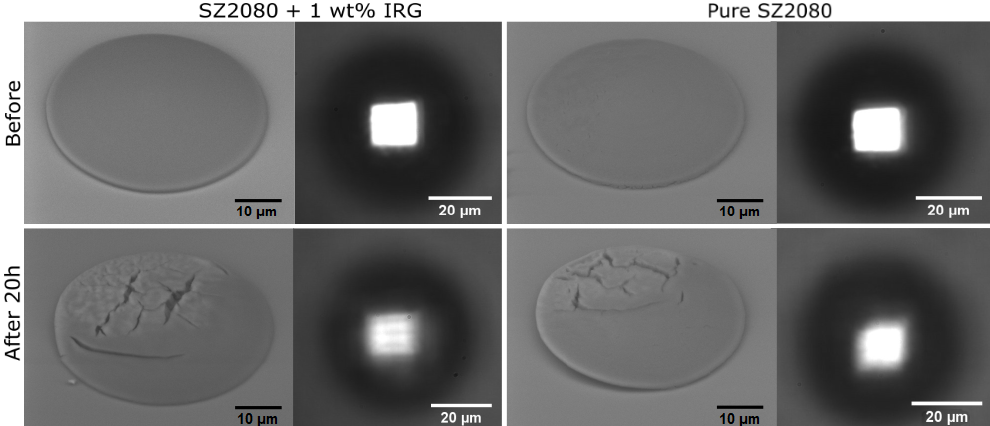
Figure 6. SEM images of microlenses before and after 20 h exposition to a loose focusing of 515 nm 300 fs laser radiation and an image of an LED made by the lens. Degradation of a lateral light distribution in the focal plane can be seen both in the structural quality of the lenses and the degraded projected image. The PI containing microlenses were more